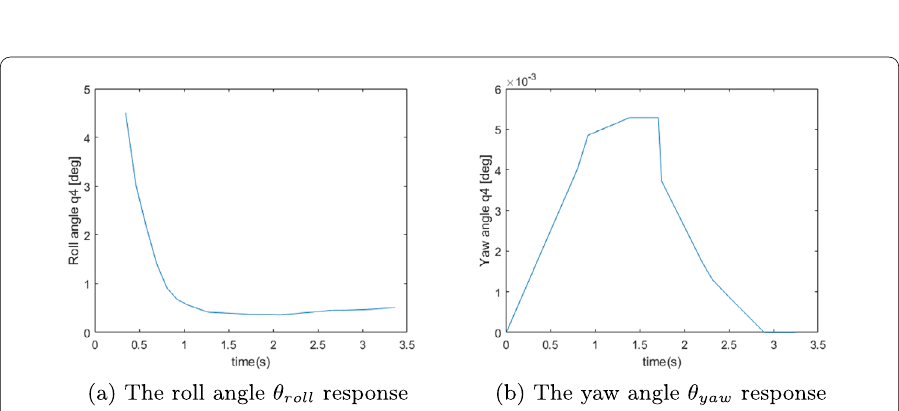
Figure 31 Backstepping control response results for the delay model with parameters c 1 = 10, c 2 = 10, c 3 =